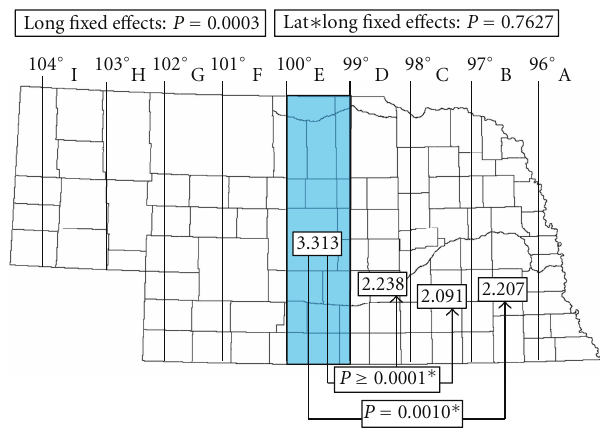
Figure 7: Mean pronotal color by code for Cicindela limbalis by lon- gitudinal region. Significant di ff erences between longitudes shown by arrows and mean value presented in each longitudinal grouping. Fixed e ff ects presented at top. No latitude by longitude interactions found. Shaded area depicts longitudinal regions di ff ering from others.